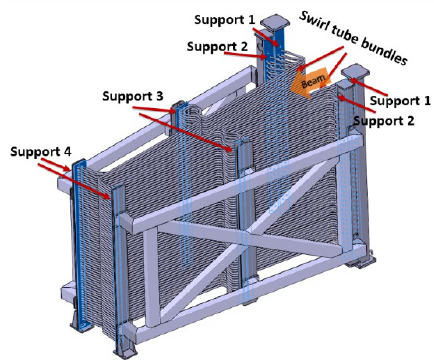
Figure 1. Calorimeter with swirl tube bundles in parallel.